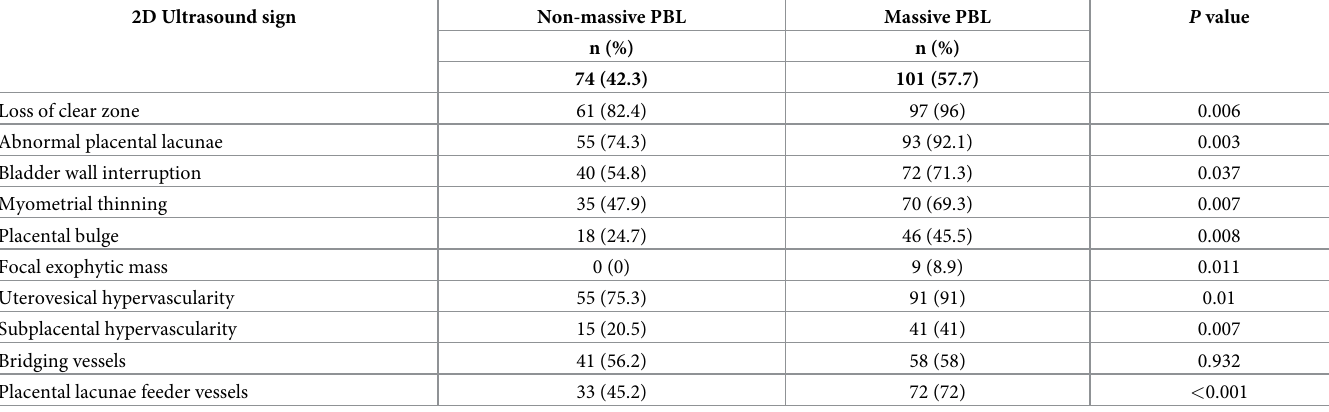
Table 2. Ultrasound signs examined in the study as predictors of massive blood loss in PAS comparing the non-massive PBL and massive PBL groups.